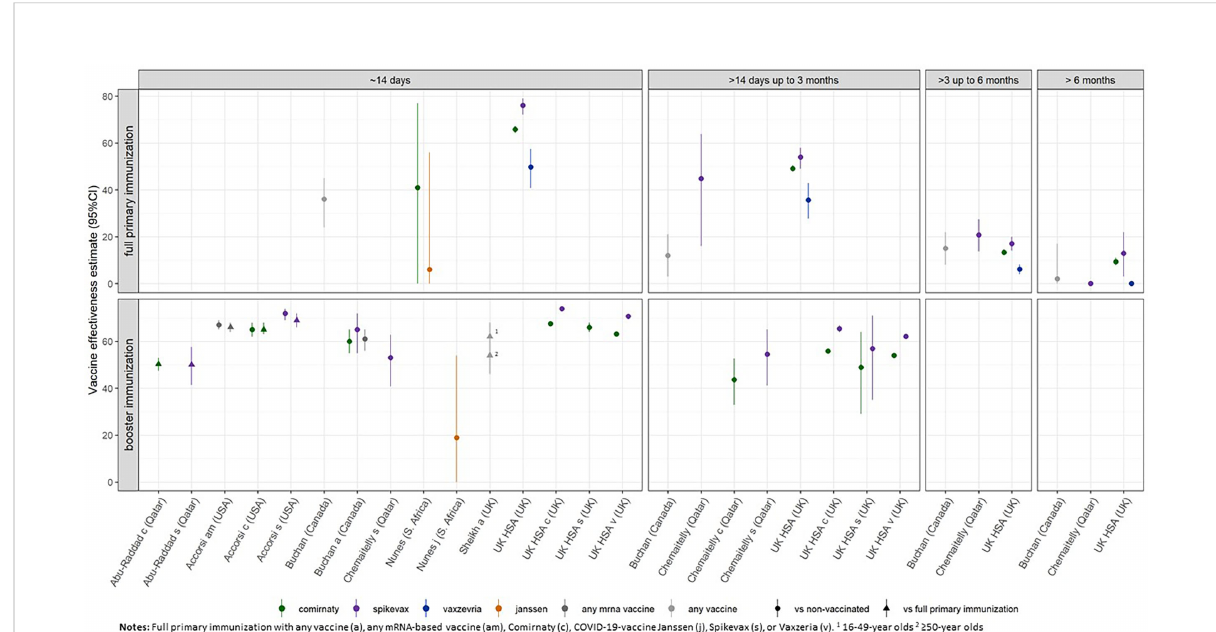
FIGURE 4 Vaccine effectiveness estimates against symptomatic COVID-19 due to SARS-CoV-2 infection of the Omicron variant after full primary immunization and booster dose, as reported in the study for the de fi ned time strata after immunization. For booster immunization the COVID- 19 vaccine used for primary immunization is